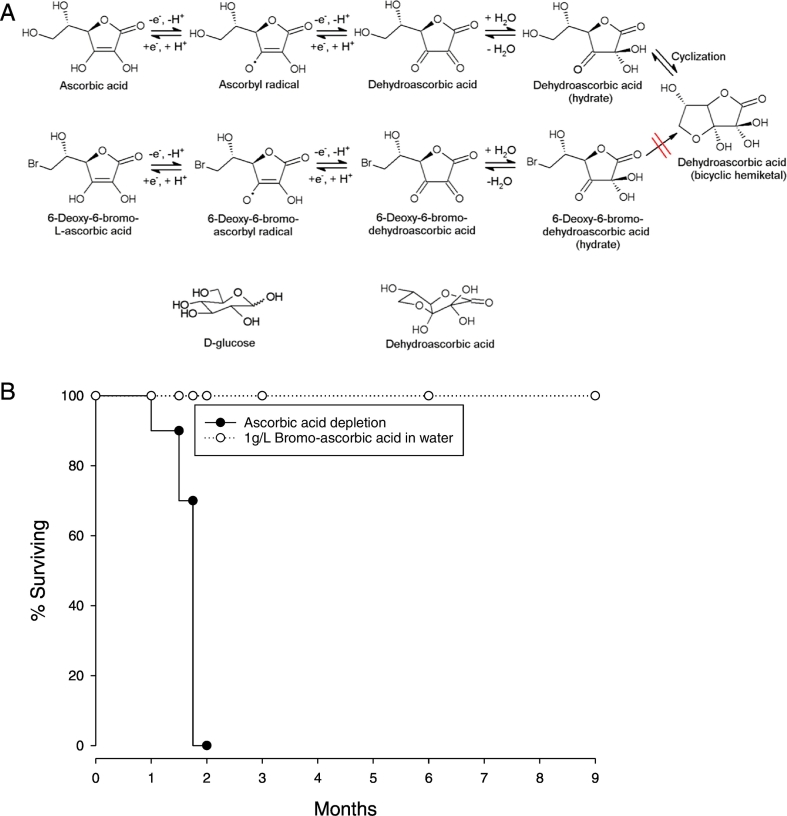
Bromoascorbate (BromoAA) as a chemical knockout for dehydroascorbic acid, and survival of gulo−/− mice raised on bromoAA. A. Structural pathway of ascorbate oxidation to dehydroascorbic acid (DHA), and bromoascorbate (bromoascorbic acid, bromoAA) to dehydrobromoascorbic acid (bromoDHA). B. Kaplan-Meier survival curves of gulo−/− mice (from 10 weeks old) depleted of ascorbate or supplemented with 1 g/L bromoAA in drinking water daily for 9 months. N = 10 mice per group.